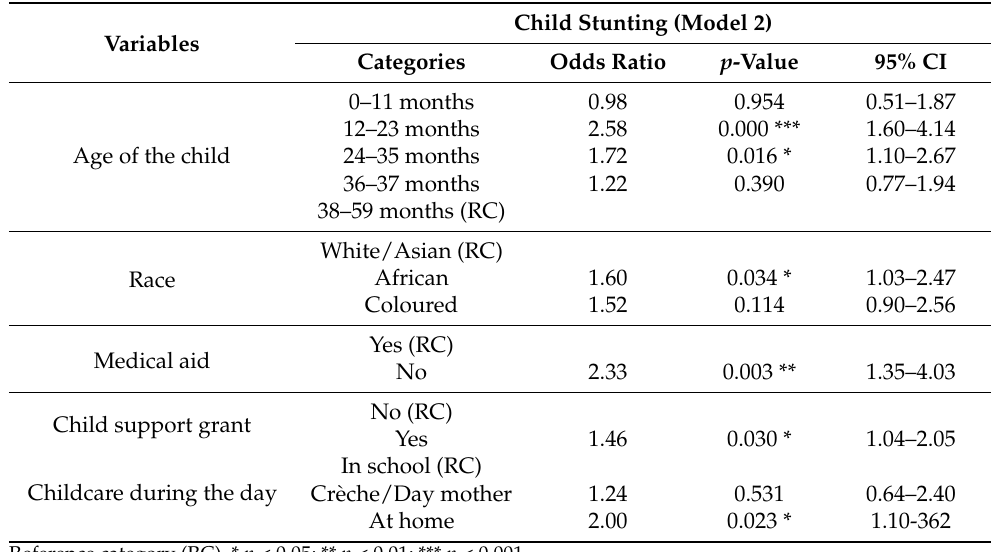
Table 5. Multivariable analysis of risk factors associated with child stunting among children under five.